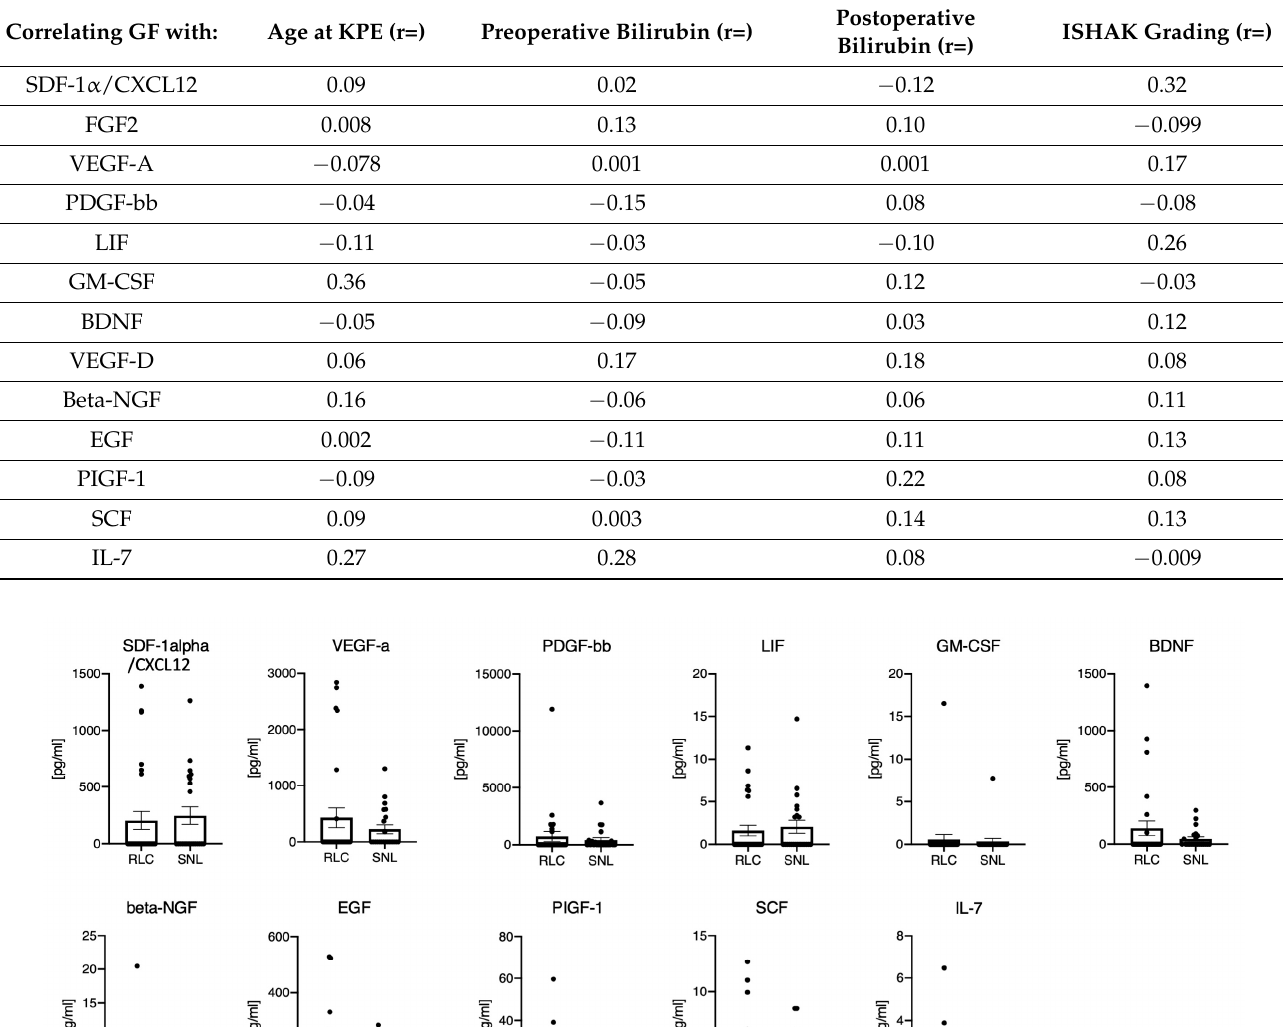
Table 3. Correlating local growth factor levels with the age at KPE (days), preoperative bilirubin ( µ mol/L), postoperative bilirubin ( µ mol/L), and Ishak score.